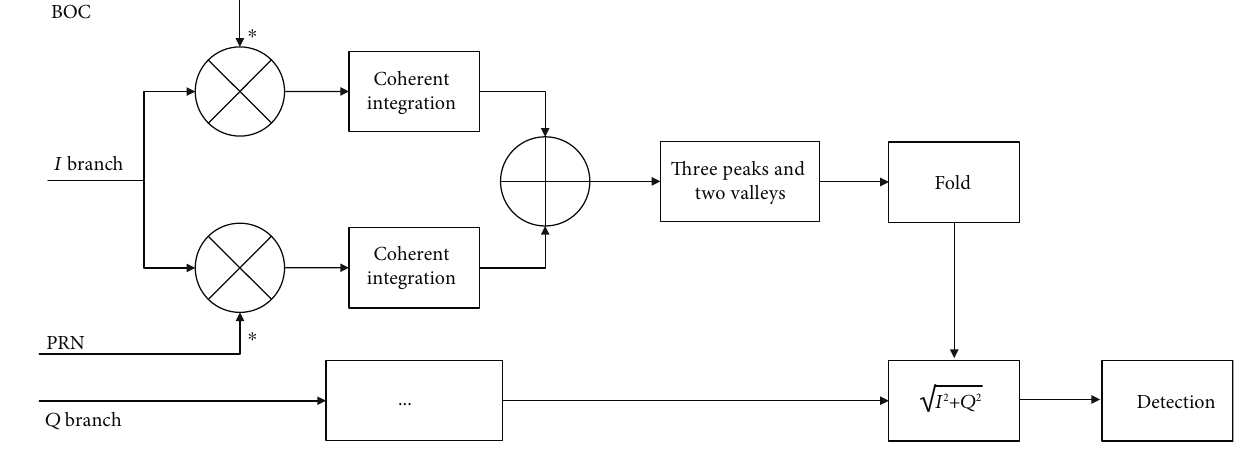
Figure 2: Flow chart of the SCPC method.